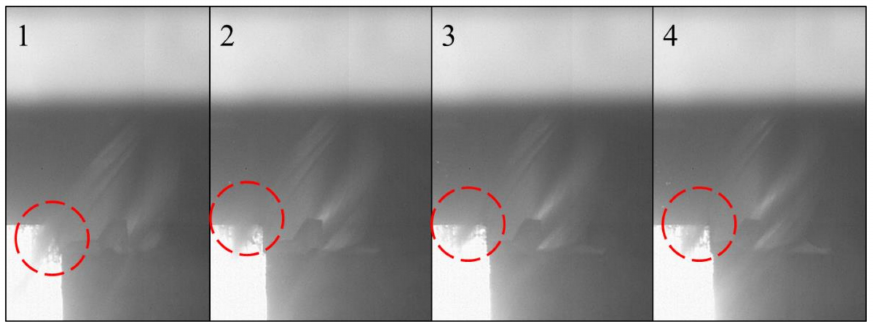
Figure 1. Cryogenic machining setup.